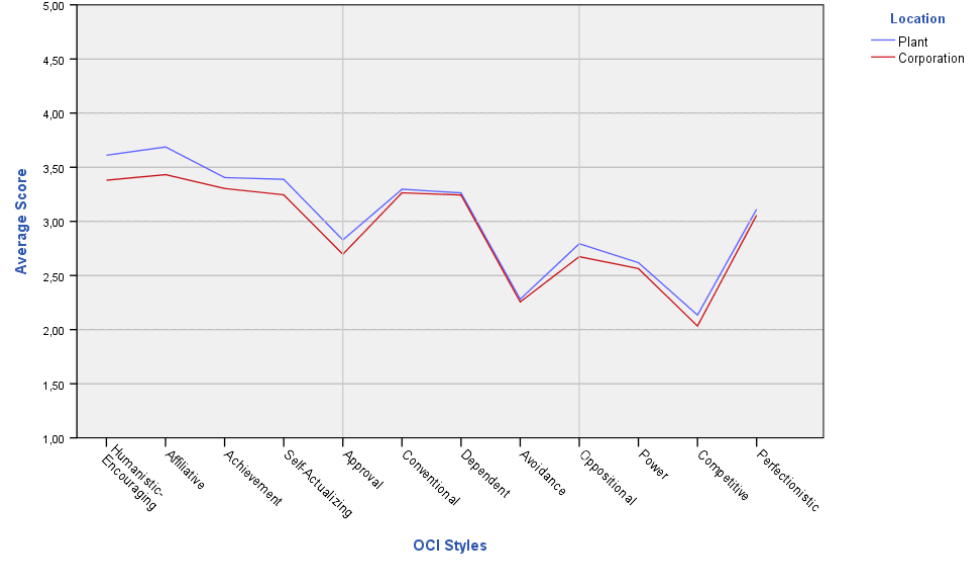
Figure 7. OCI styles averages by work